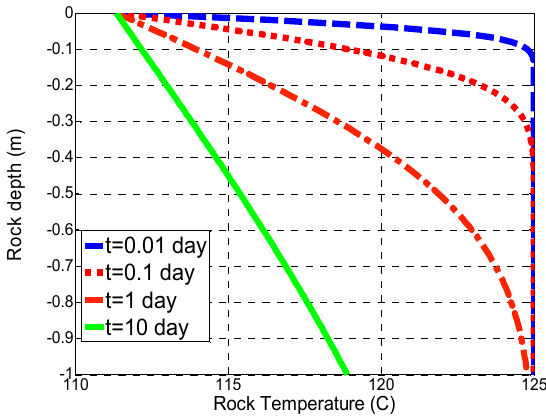
Figure 11. Cooling profile of the rock wall at x = 0.004 m for four different times: 0.01, 0.1, 1, and 10 days. Initial rock temperature is 125 °C. Fracture aperture is 0.005 m. Brine velocity is 0.0001 m/s.